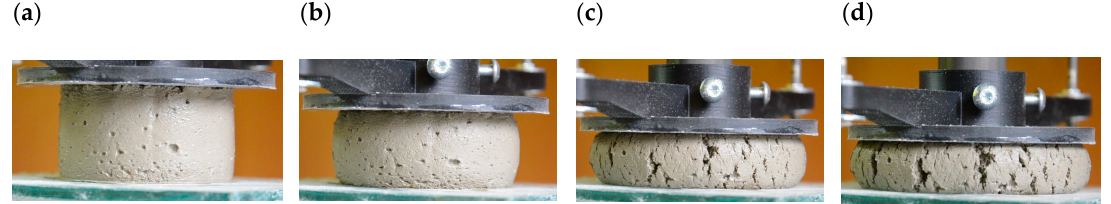
Figure 11. Analysis of specimen failure during the squeezing test—example 1.